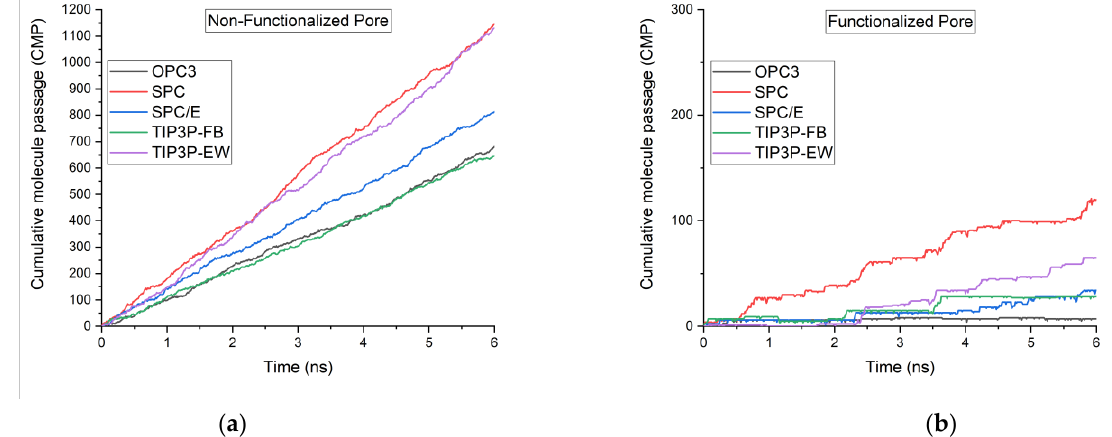
Figure 3. Cumulative water molecule passage through ( a ) multilayered non-functionalized porous graphene and ( b ) multilayered functionalized porous graphene using different water models.